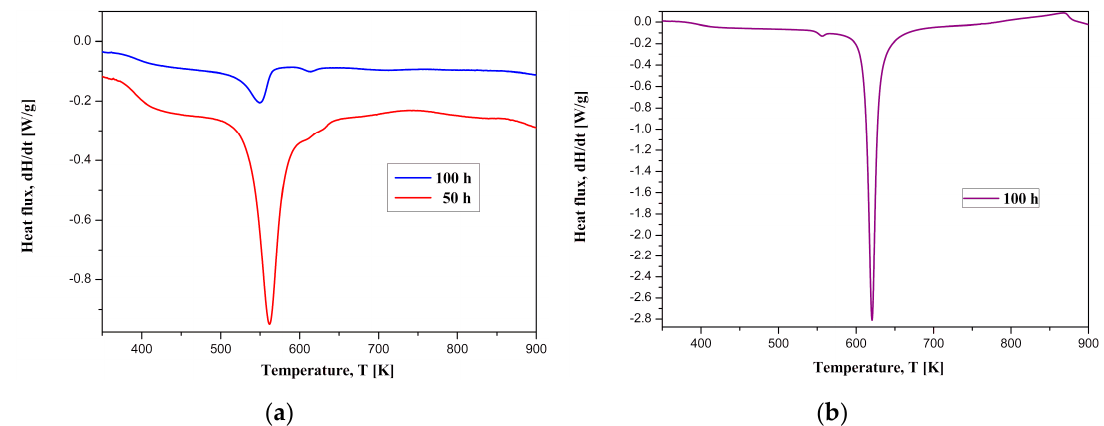
Figure 5. DSC scans at 20 K/min for: ( a ) Si-free alloy after 50 and 100 h milling ( b ) Si-containing alloy after 100 h milling.